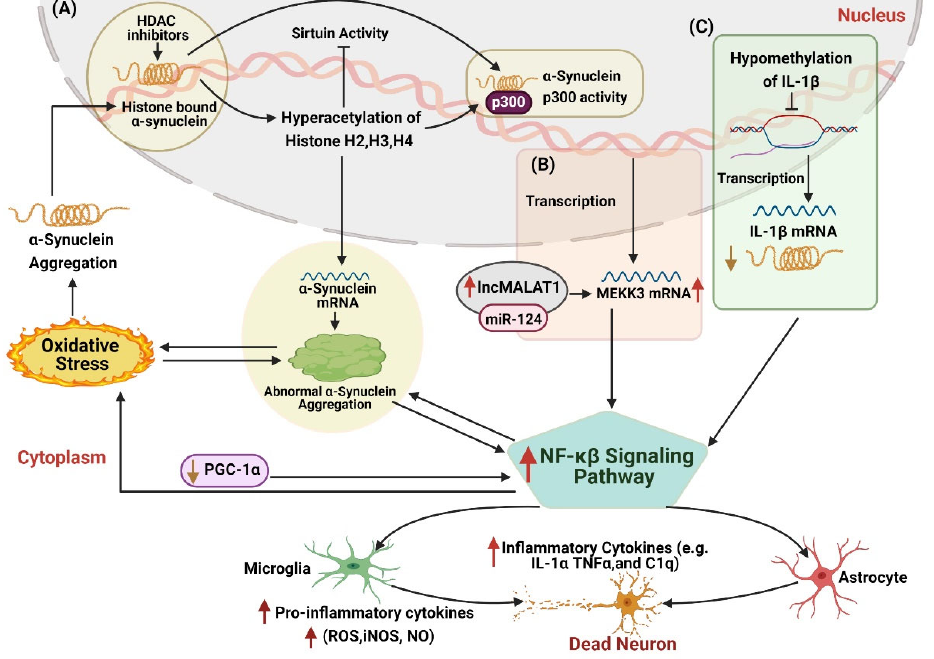
Figure 6. The landscape of synergic epigenetic interactions with NF ‐κ B signaling pathway in PD development. The NF ‐κ B signaling pathway is activated on the higher level of α‐ synuclein deposits. ( A ) Increased histone H3 acetylation overexpresses the SNCA gene and increases the release of inflammatory cytokines. ( B ) Similarly, coordination of lncMALAT1 sponging with miR ‐ 124 and MEKK3 also enhances NF ‐κ B signaling pathway activation. ( C ) Hypomethylation of IL ‐β displayed similar neuroinflammatory effects. Moreover, lower expression of PGC ‐ 1 α also contributes to NF ‐κ B signaling pathway activation. Altogether, these epigenetic mechanisms interact with each other and with NF ‐κ B signaling pathways to induce neuroinflammation in PD development. Note*: ↓ shows downregulated expression, and ↑ shows an upregulated expression.